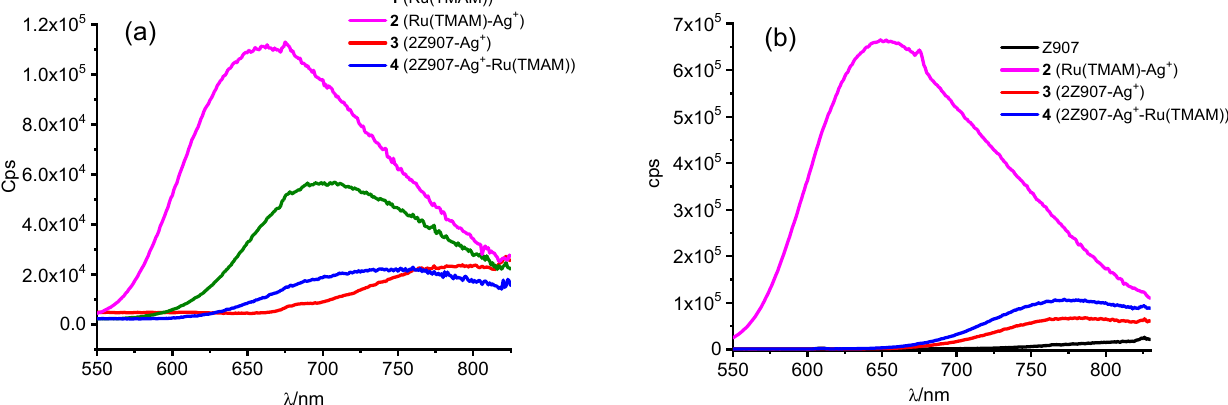
Figure 4. Emission spectra ( λ exc = 450 nm) of ( a ) 1 Ru(TMAM) (green line), 2 (Ru(TMAM)-Ag + ) (purple line), 3 (2Z907-Ag + ) (red line), and 4 (2Z907-Ag + -Ru(TMAM)) (blue line) in ethanolic solutions and of ( b ) Z907 (black line), 2 (Ru(TMAM)-Ag + ) (purple line), 3 (2Z907-Ag + ) (red line), and 4 (2Z907-Ag + -Ru(TMAM)) (blue line) supported on ZrO 2 .